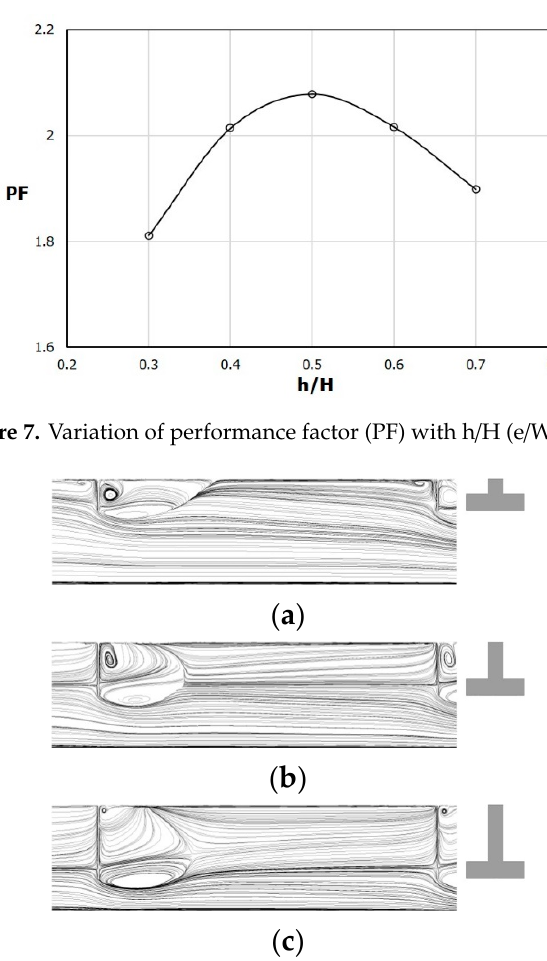
Figure 8. Streamlines on x-y plane (z = 0) between fifth and seventh ribs (dark region in Figure 1b) for different h/H. ( a ) h/H = 0.3, ( b ) h/H = 0.5, ( c ) h/H = 0.7.